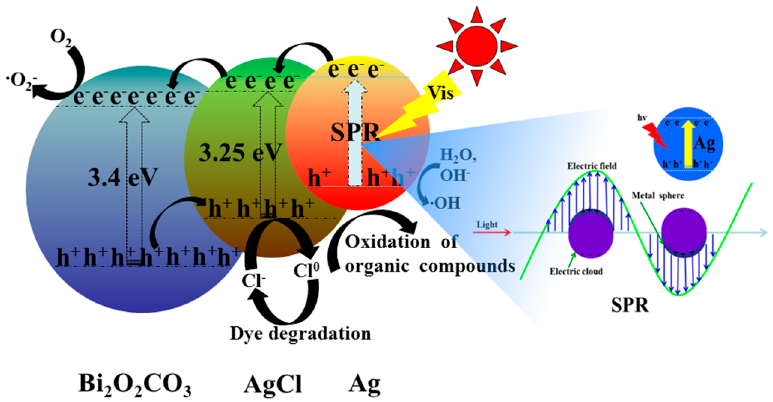
Figure 15. Mechanism of the photocatalytic degradation of MB over Ag@AgCl/Bi 2 O 2 CO 3 .